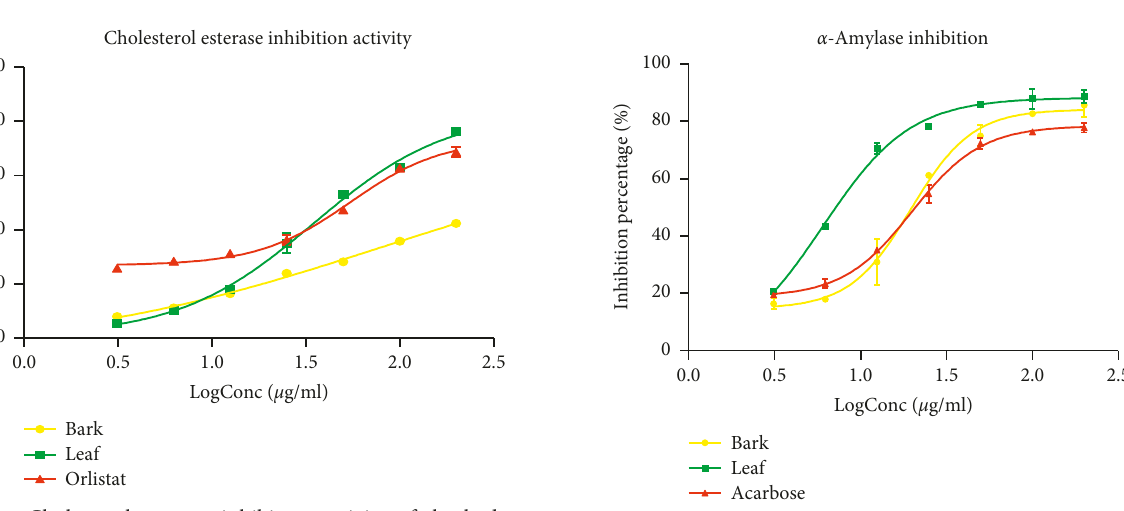
Figure 8: α -Amylase inhibitory activity of the hydro-ethanolic leaf and bark extract of Psychotria densinervia and acarbose. Values are expressed as mean ± SD ( n � 3).